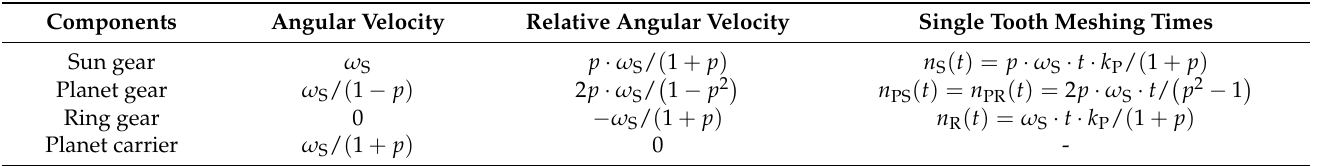
Table 6. Kinematic parameter of planetary gear